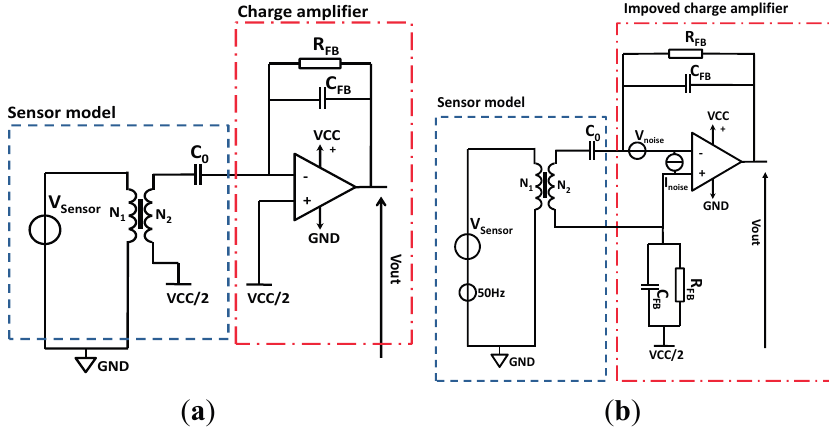
Figure 7. ( a ) PZT Sensor and bounding model with a conditioning circuit; ( b ) PZT Sensor and bonding model with an improved conditioning circuit using differential inputs.